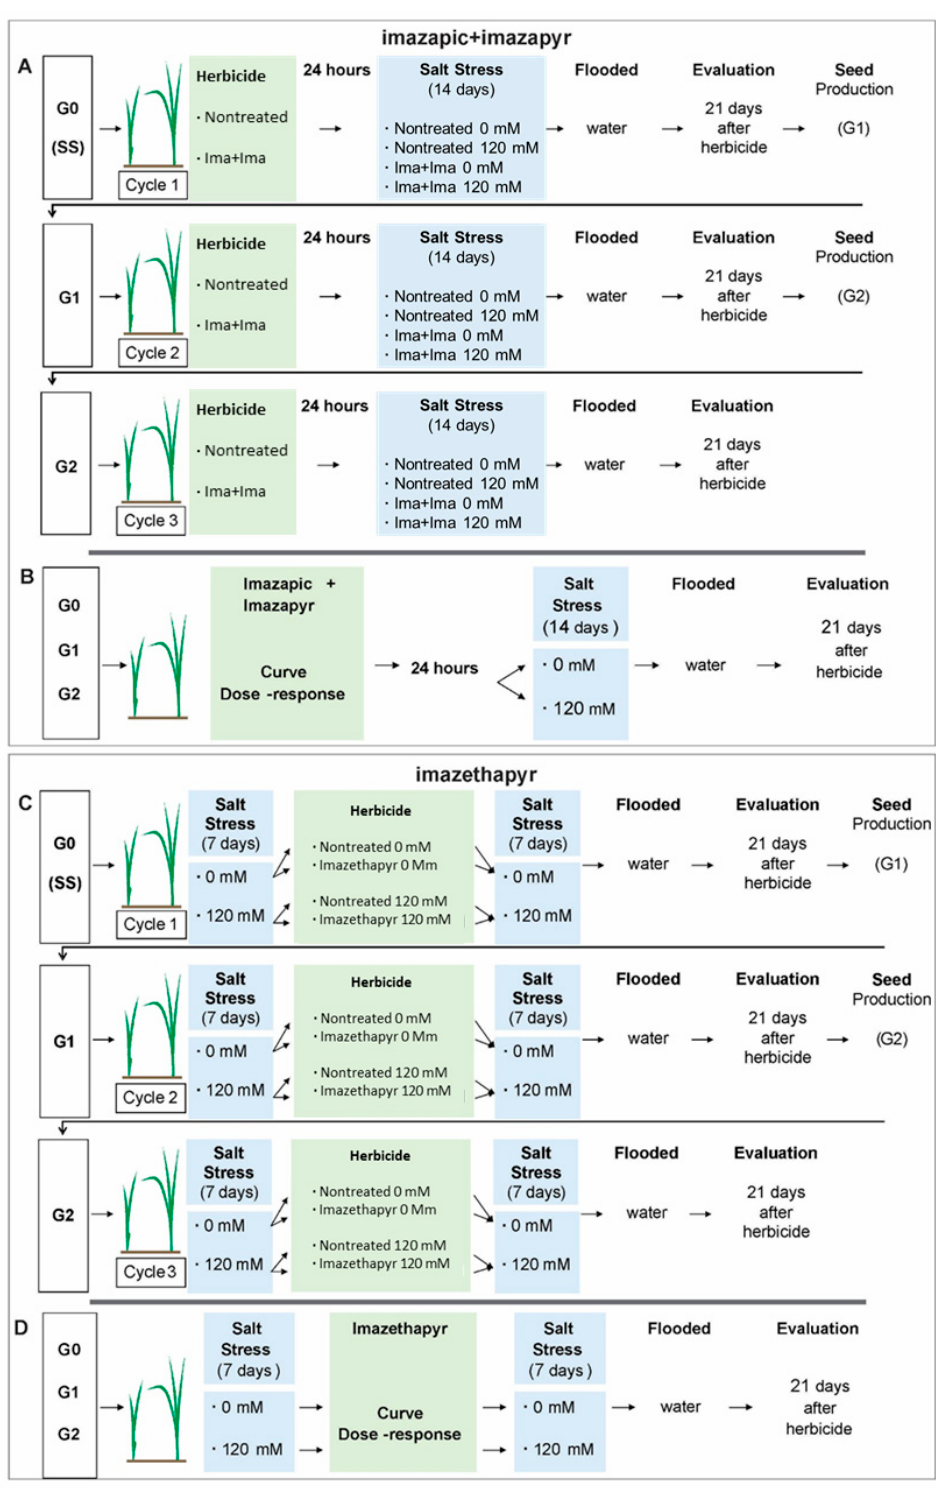
Figure 1. Schematic diagram of the progression of experiments on Echinochloa colona . ( A ) The low dose of imazapic + imazapyr and stress by salt. Parental population from the susceptible standard (G0) and selected (G1 and G2) progenies. Salt was applied at 120 mM. The sublethal herbicide dose was: nontreated check (no herbicide) and the formulated mixture of imazapic + imazapyr (at 0.125× the recommended dose). ( B ) Schematic diagram of the curve dose-response procedure on E. colona to imazapic + imazapyr. ( C ) The low dose of imazethapyr (0.125× the recommended dose) and stress by salt. ( D ) Schematic diagram of the curve dose-response procedure on E. colona to imazethapyr.